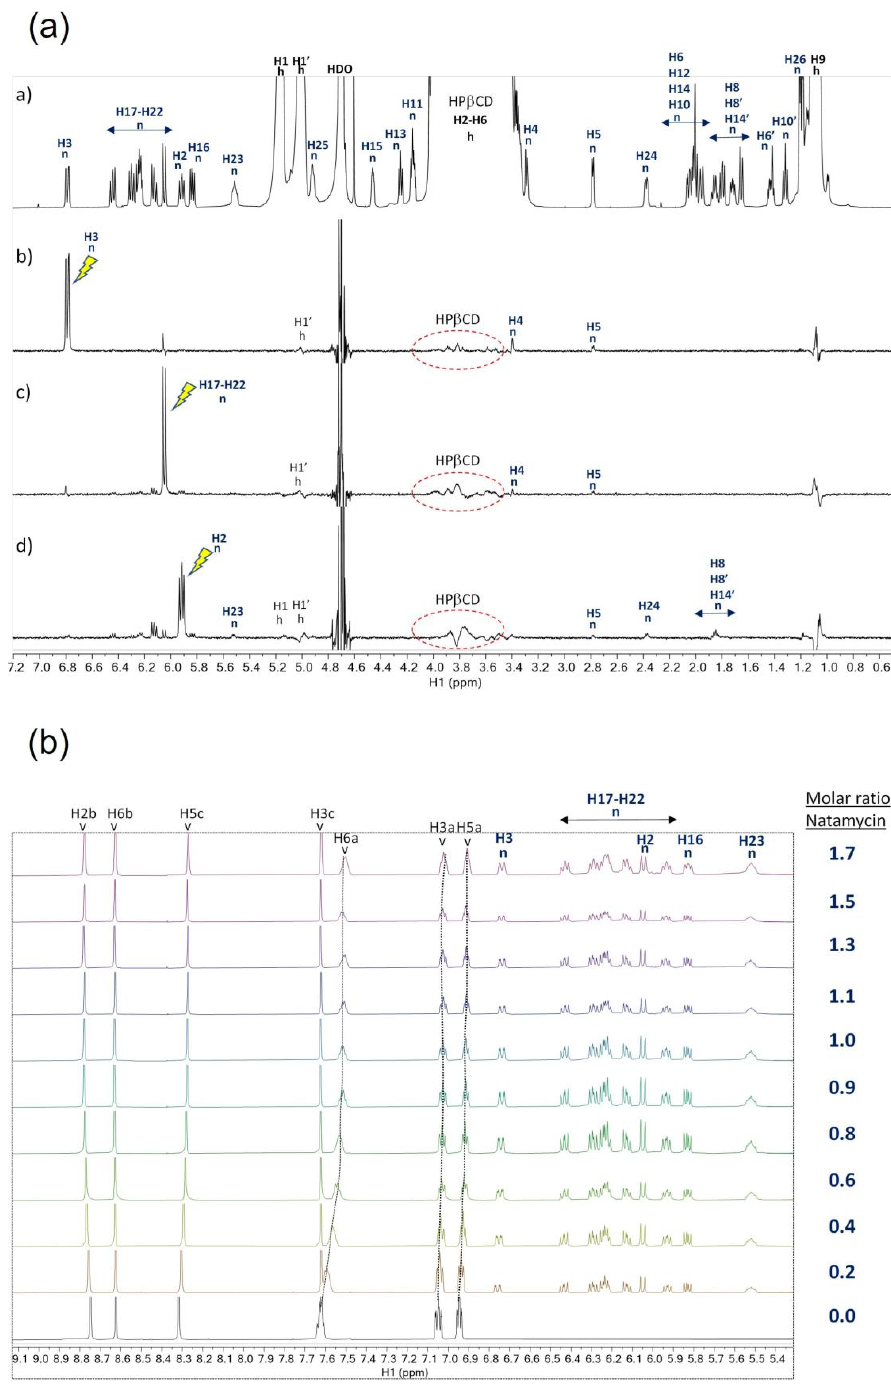
Figure 4. ( a ) NMR spectra of natamycin:HP β CD 1:1 in D 2 O showing the assignment of signals of natamycin (n) and HP β CD (h). (a) 1 H reference spectrum. (b) STD off-on spectrum with on-saturation at 6.79 ppm (H-3 signal of n). (c) STD off-on with on-saturation at 6.05 ppm (H-17 to H-22 signal of n). (d) STD off-on with on-saturation at 5.91 ppm (H-2 signal of n). The atom numbering used to identify the signals of voriconazole follows S1. ( b ) NMR titration competition assay with natamycin at a constant molar ratio voriconazole:HP β CD 1:1. Stack of spectra showing the aromatic region of the 1 H-NMR spectrum during the titration. The atom numbering used to identify voriconazole (v) and natamycin (n) follows S1. Stripped lines were drawn to guide the eye for the changes in chemical shift (i.e., CSPs) of certain signals of